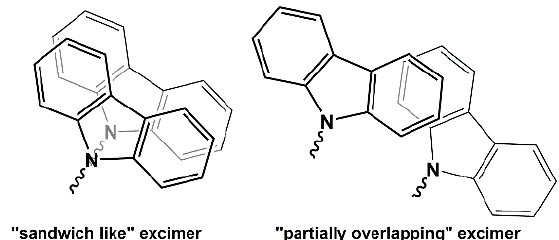
Figure 8. Photoluminescence spectra of PPO- b -PEPK ( A ) solution (THF, 1 mg/mL).and ( B ) film. Λ ecc = 290 nm.